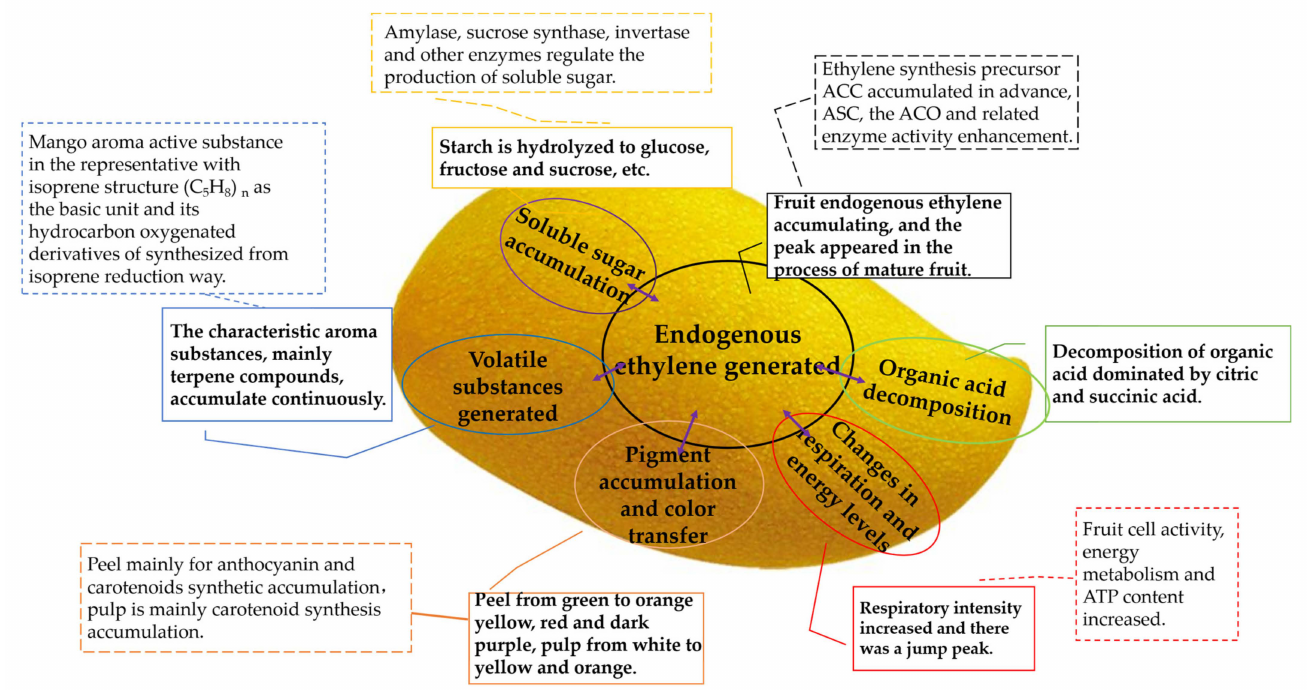
Figure 2. The main physiological changes in mangoes during